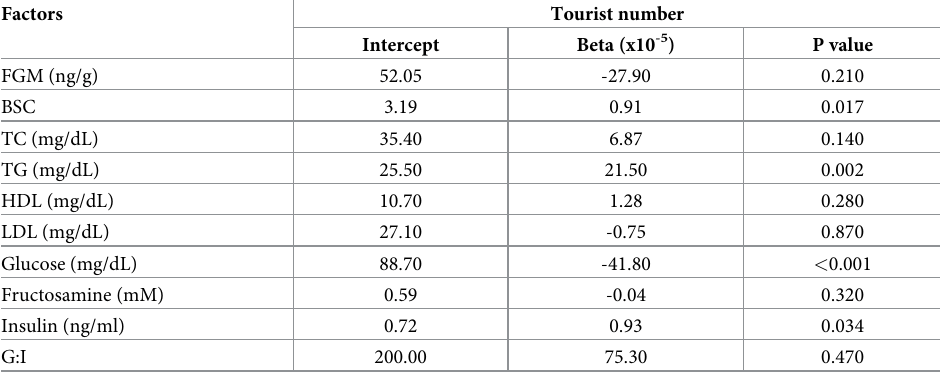
Table 5. Relationships between tourist number and health factors and adrenal steroid activity in captive Asian elephants in Thailand. Fecal samples were collected for FGM analyses, and visual body condition scores were deter- mined based on a set of photographs. Blood samples were collected to assess lipid and metabolic status. Data were ana- lyzed by GEE to determine the effect of tourist numbers on physiological function of 33 elephants housed at five elephant camps in Northern Thailand.